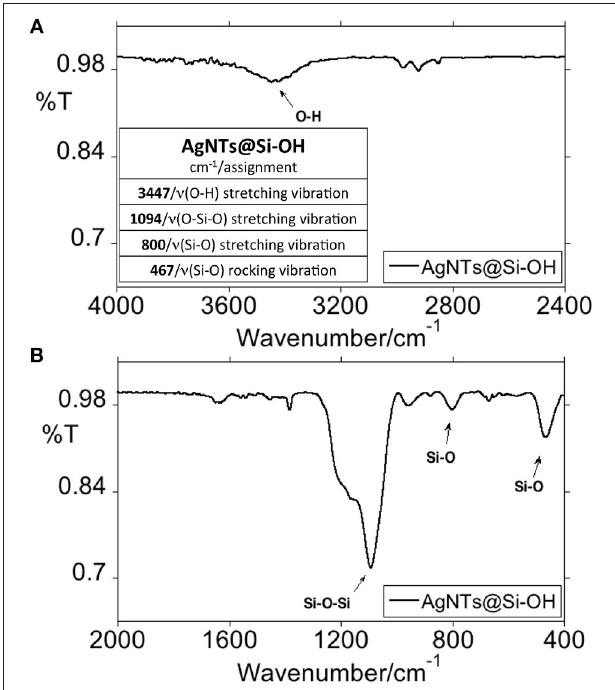
FIGURE 6 | FT-IR spectroscopic profile of AgNTs@Si-OH in KBr disk. Overview between 4,000 and 2,400 cm − 1 and peak table (A) and 2,000 and 400 cm − 1 (B) .